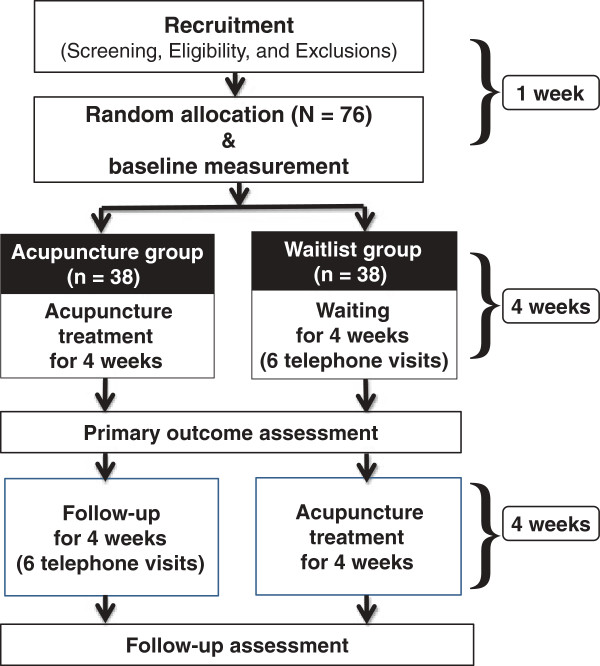
Flow of the study.